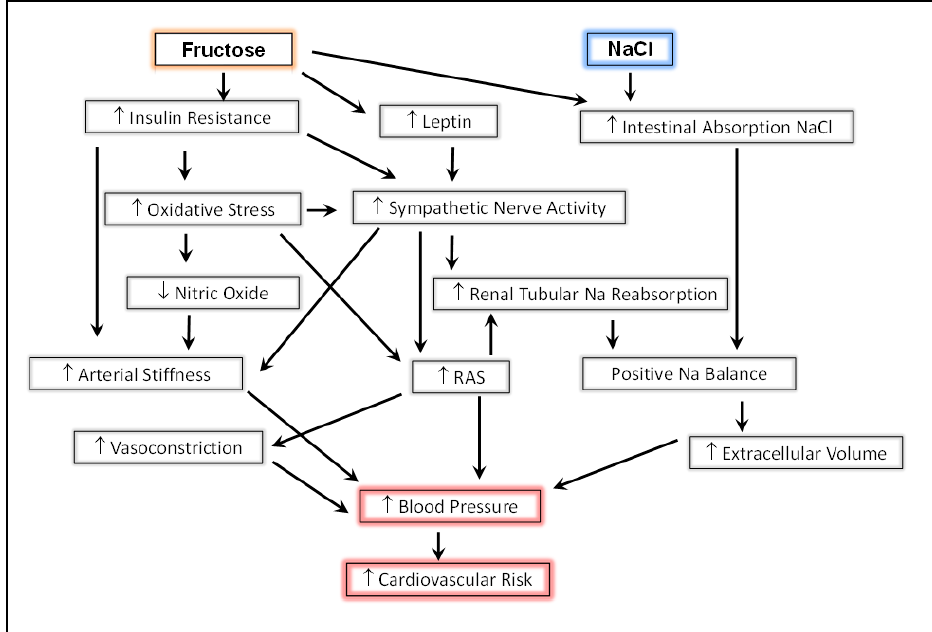
Figure 1. Interactions of pathways resulting in hypertension and increased cardiovascular risk induced by excess fructose and salt consumption (see text). RAS, renin angiotensin system.